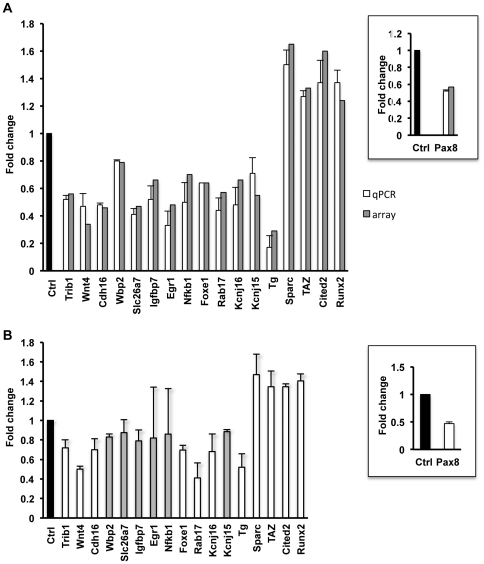
Validation of the microarray results by qRT-PCR.Transcript abundance of 17 selected genes was measured by qRT-PCR. Relative gene expression in siPax8 transfectants was calculated using non-targeting siRNA transfectant RNA (Ctrl) as reference. A) Differential gene expression in siPax8 vs Ctrl cells, 72 h after Pax8 silencing: comparison between qRT-PCR and array data validates array results with a correlation coefficient r > 0.80. B) Differential gene expression in siPax8 vs Ctrl cells, 24 h after Pax8 silencing. The experiment was repeated three times on different biological replicates. White bars indicate differentially expressed genes with absolute fold change>1.2 and high statistical significance (p<0.05 for t-test). These genes are presumably direct Pax8 targets. In both panels, the fold change of Pax8 expression level is shown in the insert.